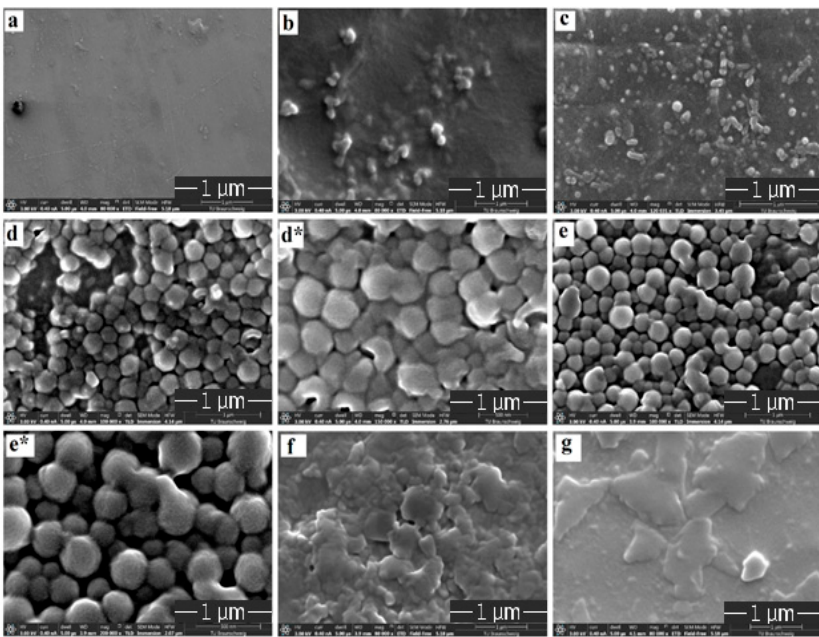
Figure 1. SEM images of ( a ) chitosan, ( b ) patch-0.5, ( c ) patch-1, ( d ) patch-3, ( d* ) zoomed image of patch - 3, ( e ) patch-5, ( e* ) zoomed image of patch - 5, ( f ) patch - 7 and ( g ) patch - 10.